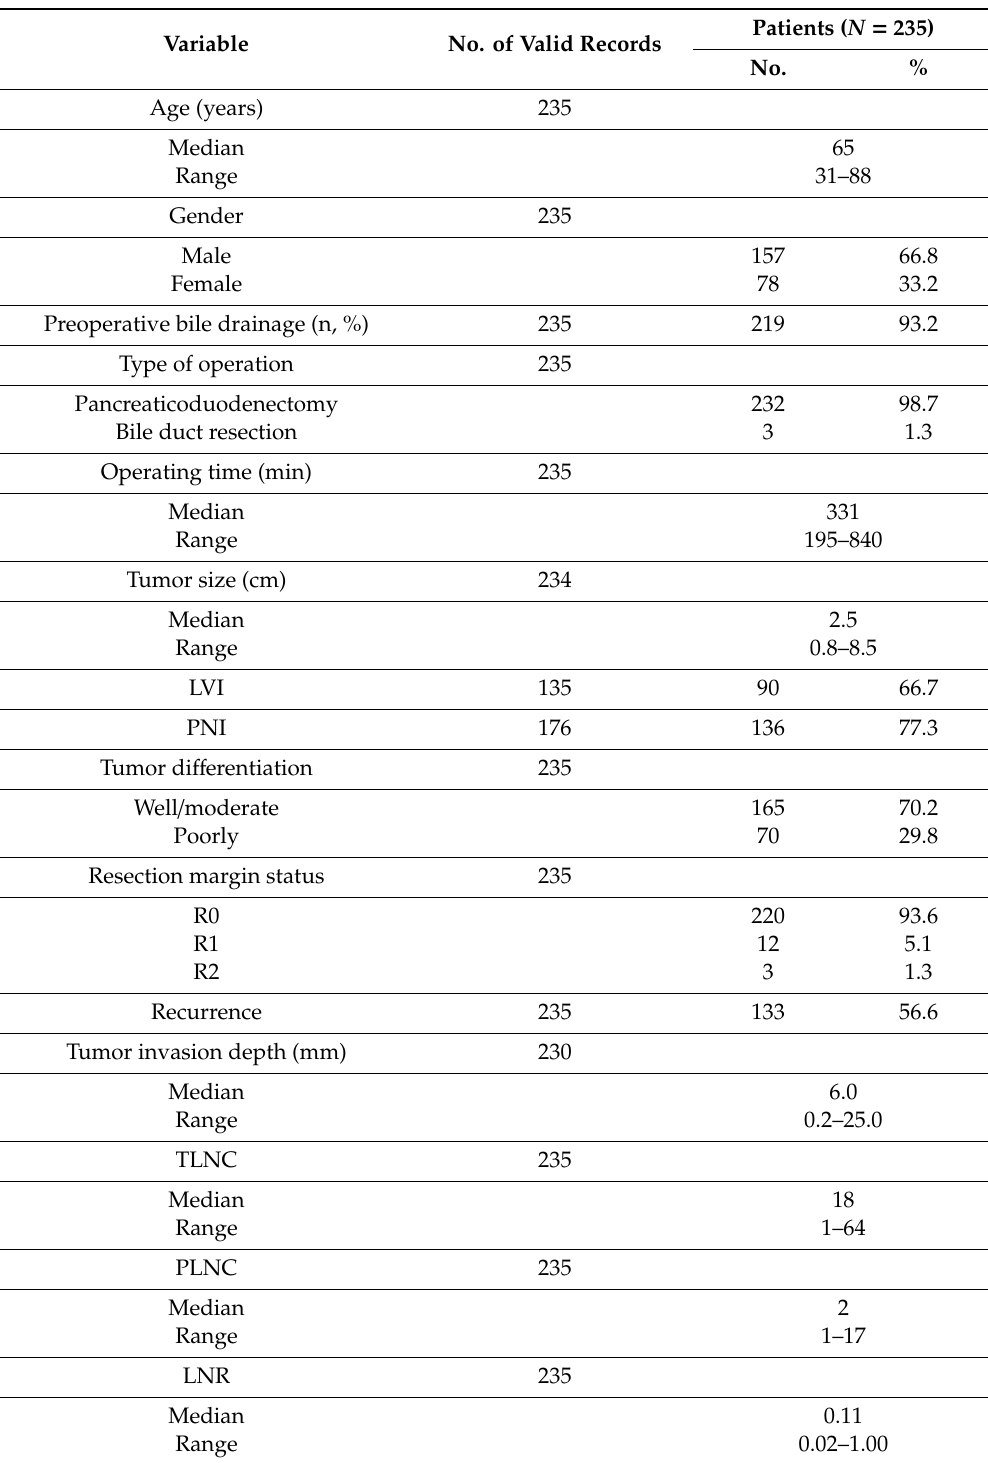
Table 1. Clinical and pathological data of